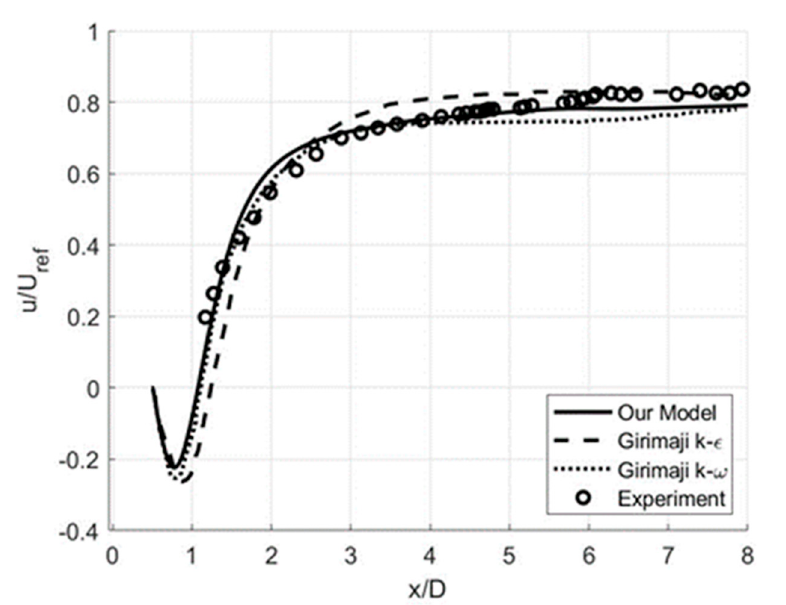
Figure 14. The mean centerline streamwise velocity profile (𝑓 (cid:3084) = 1.0, 𝑓 (cid:3038) = 0.7).